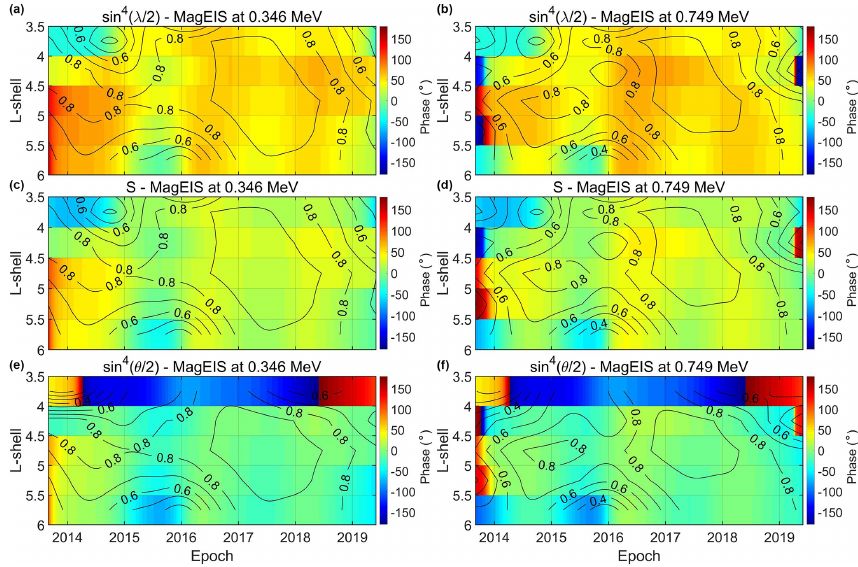
Figure 8. Phase relationship between electron fluxes and the three angle functions as inferred from the XWT spectrum as a function of L shell and time. Panels (a, c, e) correspond to 0.346 and panels (b, d, f) to 0.749MeV electrons from MagEIS. The phase relationship between the flux and λ (a, b) , ψ (c, d) and θ (e, f) functions, which control the axial, equinoctial and RM mechanism, respectively. The black contours correspond to the coherence level estimator as inferred from WTC.